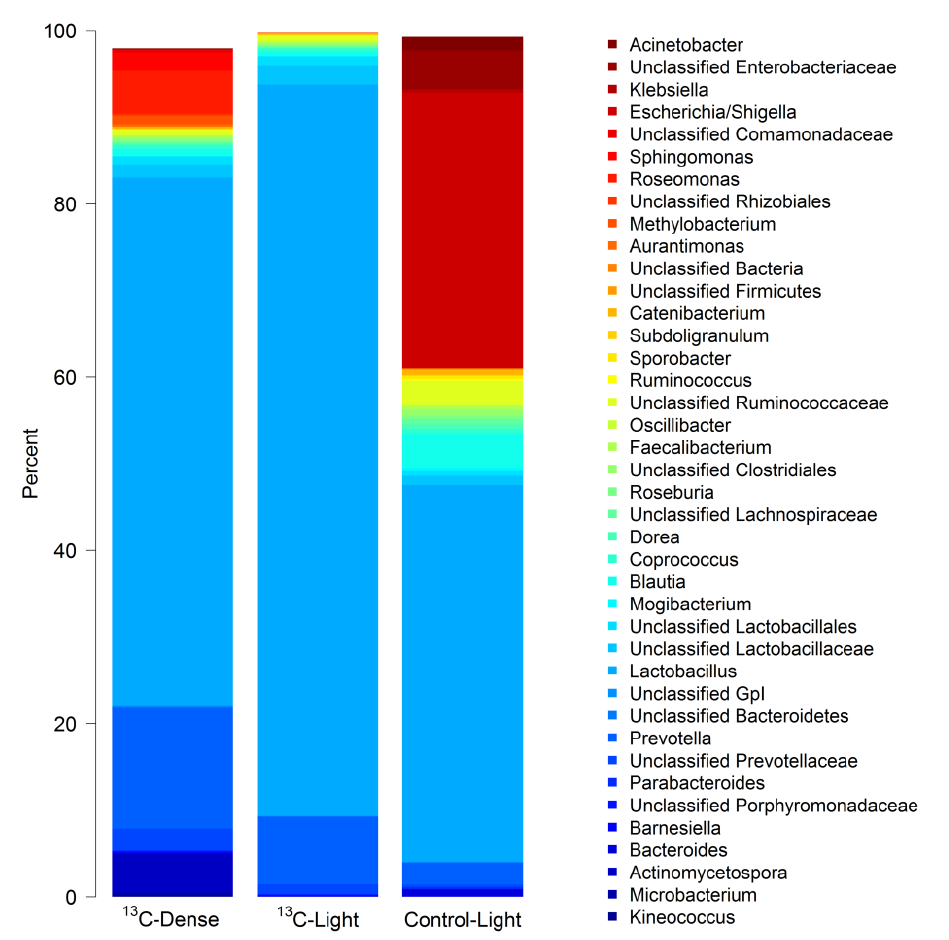
Figure 3. Stacked barplot showing the mean genus level composition of density gradient fractions from independent cultures (3 piglets). Bars labelled 13 C-Dense represent the mean composition of fractions 4–6 in cultures with 13 C-sialic acid; 13 C-Light represents the mean composition of fractions 12–14 in cultures with 13 C-sialic acid; Control-Light represents the mean composition of fractions 12–14 in control cultures without sialic acid. The bacteria shown are the 40 taxa with the highest mean relative abundance across all